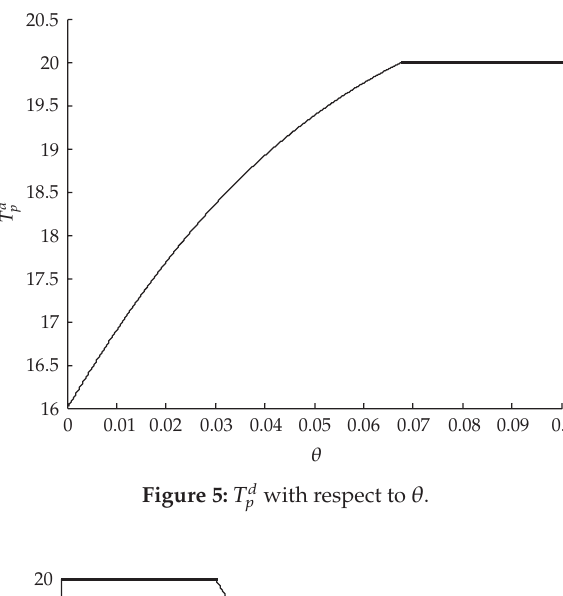
with respect to θ . p